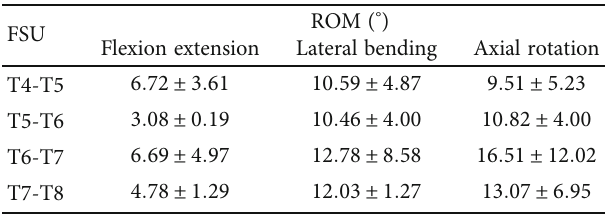
Table 2: Porcine spine data of the ROM for each DOF of each specimen at moment of ±